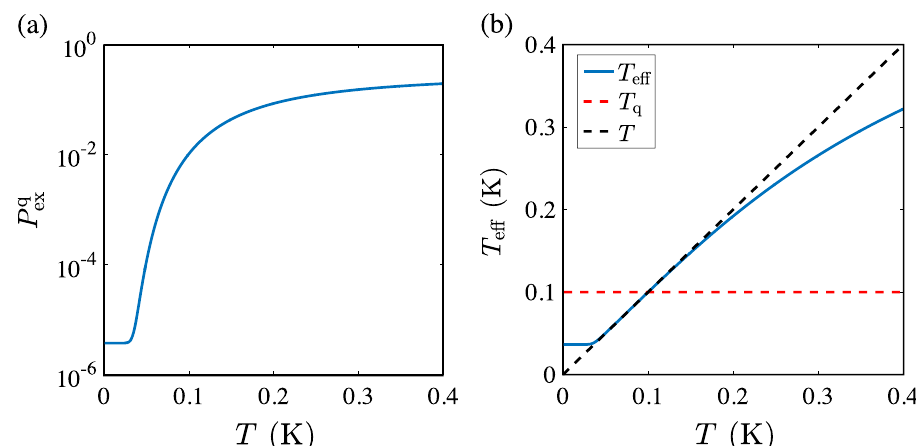
Fig. 4 a Analytic excited state occupation P q ; and b the corresponding effective qubit temperature T eff after the initialization protocol as ex functions of the resistor temperature T , cf . Eq. (29). In b , we also plot the temperatures for the intrinsic qubit ( red dashed line ) the resistive bath ( black dashed line ). We use the intrinsic qubit temperature T q = 100 mK and the intrinsic relaxation rate κ I